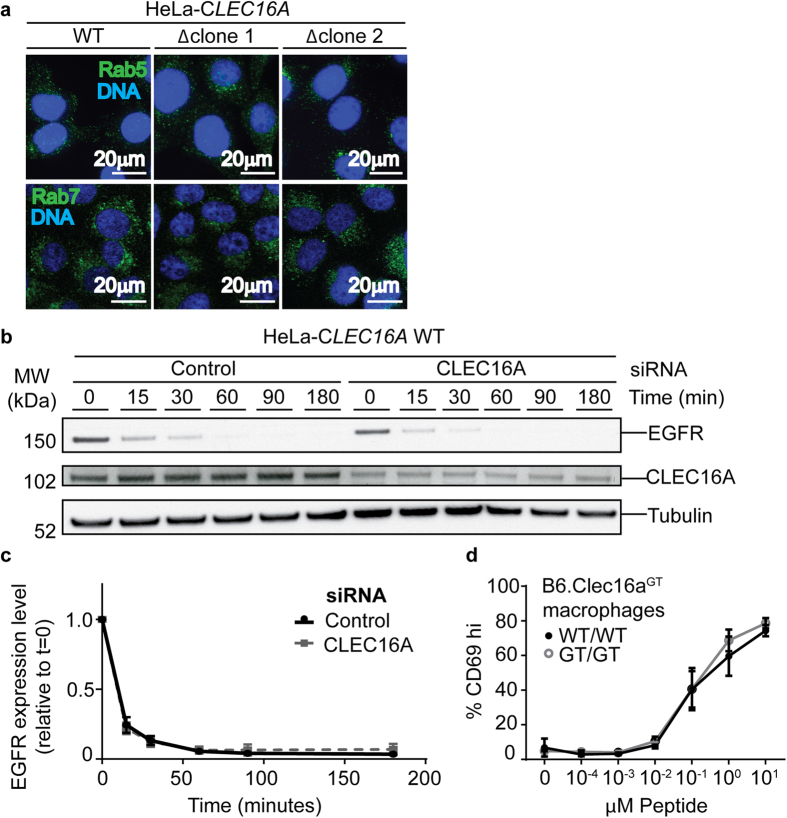
Functional endolysosomal system in Clec16a-mutant cells.(a) Confocal microscopy images of HeLa-CLEC16A cells stained for Rab5 and Rab7 (representative of n = 3 experiments). (b,c) EGF receptor degradation assay in control cells or cells with reduced CLEC16A protein by siRNA transfection (representative of n = 3 experiments). (d) Co-culture assays measuring T-cell proliferation in response to B6.Clec16aGT macrophages pulsed with Listeria monocytogenes–specific peptide (representative of n = 4 experiments).